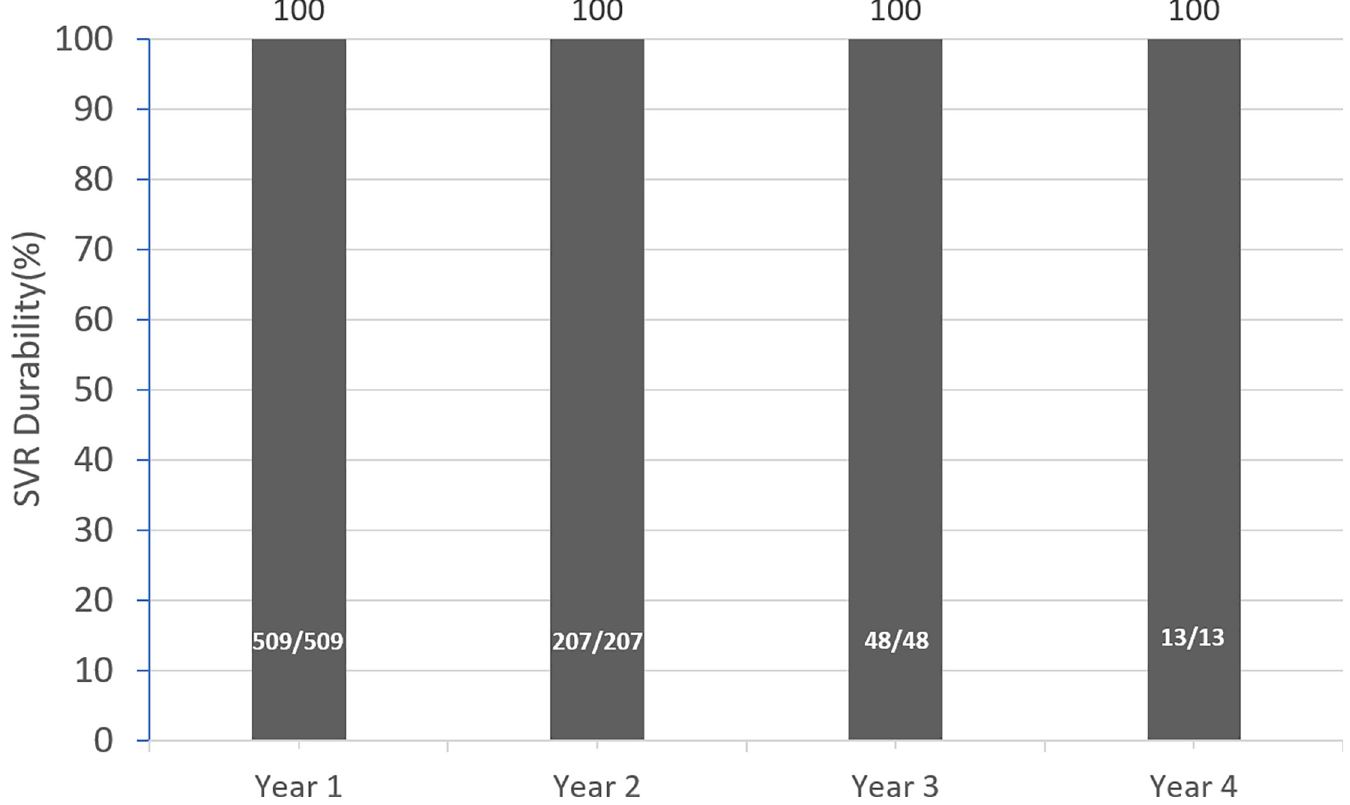
and SVR24 were highly concordant, which was in line with previous studies [11, 19]. The cur- rent study reinforced the recommendation of regional guidelines [20], which stated that both SVR12 and SVR24 could serve as the endpoints of therapy given > 99% concordance. Reddy